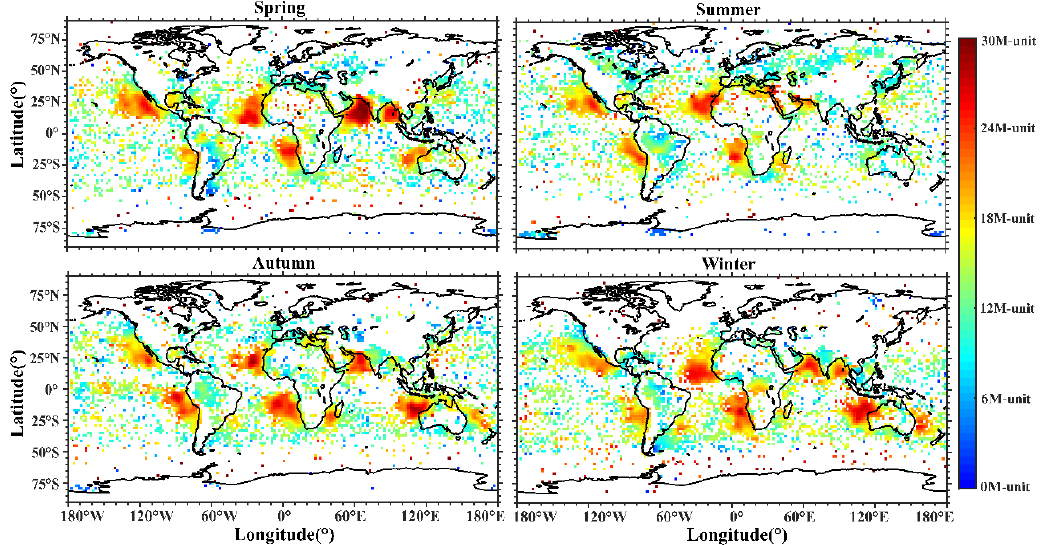
Figure 9. Distribution of the trapping layer intensity with season variations. The blank grids represent that there is no trapping layer event.